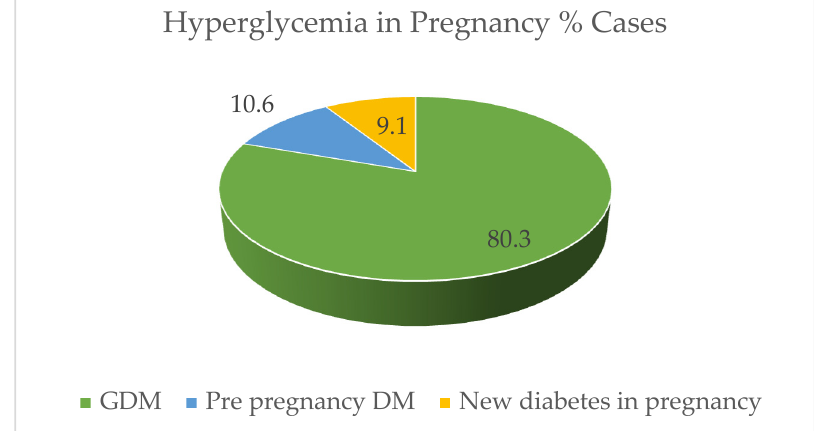
Figure 2. Hyperglycemia in pregnancy. (International Diabetes Federation [7]).